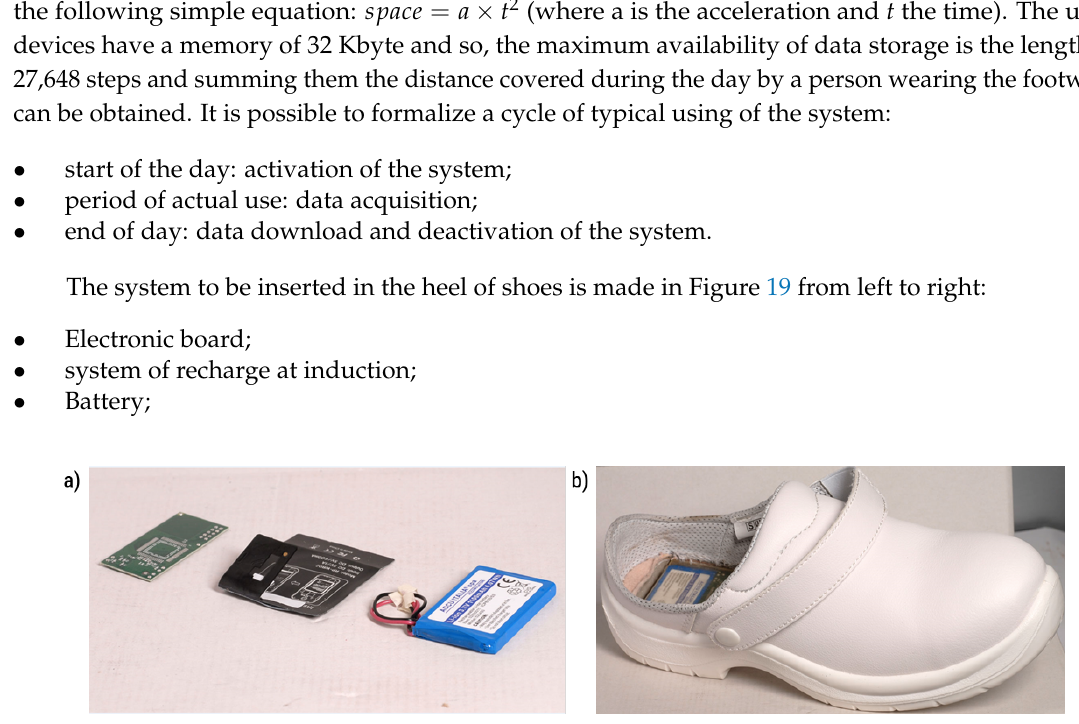
Figure 19. Components ( a ) inserted in the heel and the shoe prototype ( b